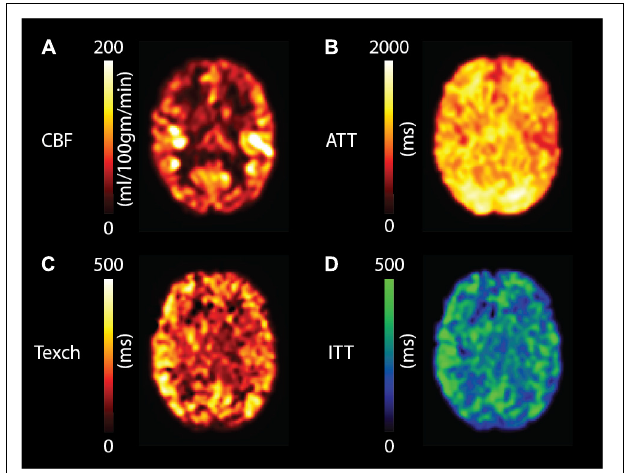
FIGURE 7 | Texch and ITT whole-brain parameter maps from all 10 subjects in standard MNI space (middle slice). It can be seen that the two-compartment model estimates comparatively higher values of Texch.